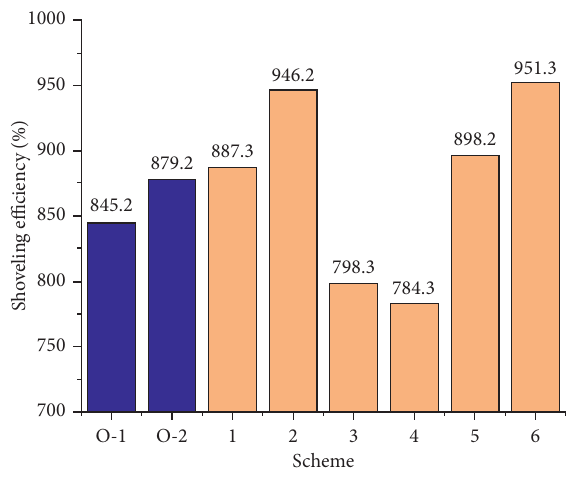
Figure 9: Statistic chart of shoveling